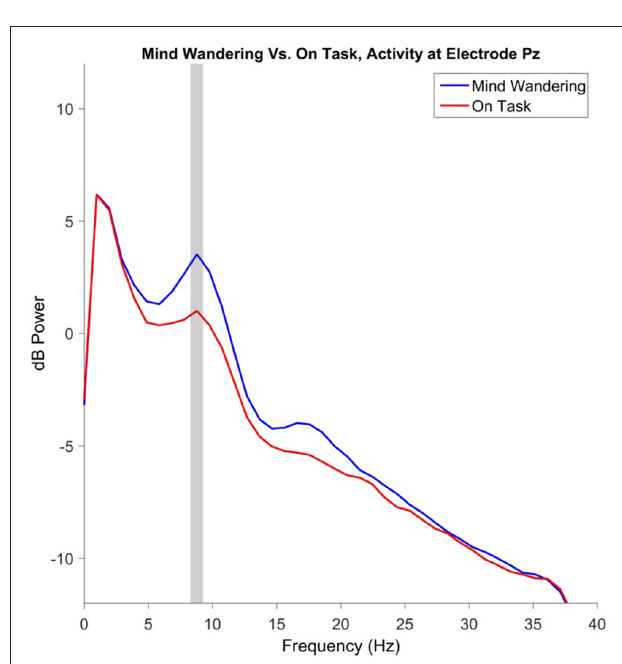
FIGURE 8 | Electroencephalography (EEG) power spectrum at parietal electrode site Pz, preceding “mind wandering” vs. “on task” responses. The shaded gray region represents the width of the frequency bin defined as alpha, identified via inspection of the grand mean of both “mind wandering” and “on task”